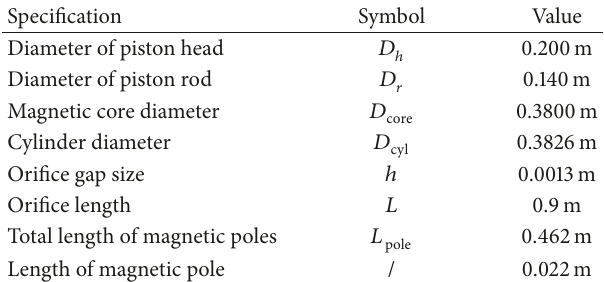
Table 3: Geometric specifications of the MR impact